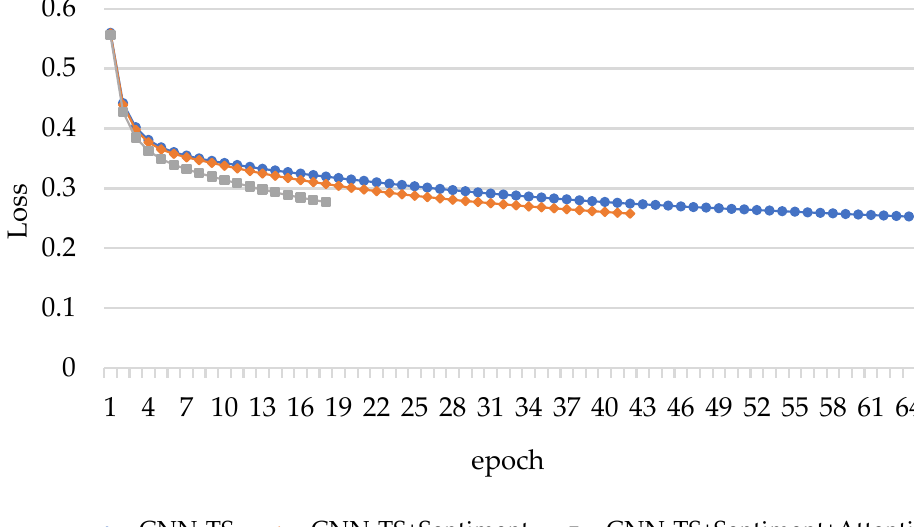
Figure 6. Iteration times and losses of CNN-TS, CNN-TS + Sentiment, CNN-TS + Sentiment + Atten- tion.